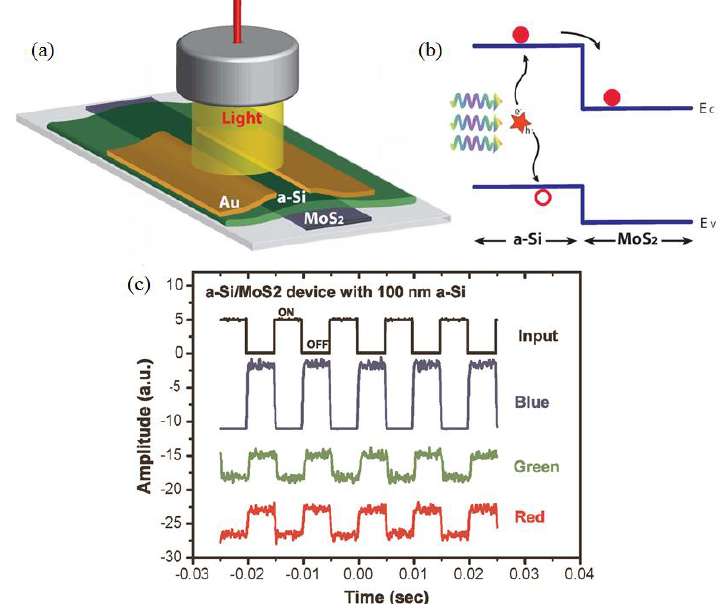
Figure 12. ( a ) Schematic of a-Si/MoS 2 heterojunction photodetector; ( b ) Energy band diagram of a-Si/MoS 2 heterojunction photodetector; ( c ) Transient responses of the device for three incident wavelengths [31] (Reproduced with permission from Esmaeili-Rad et al. , Sci. Rep. ; published by NPG,